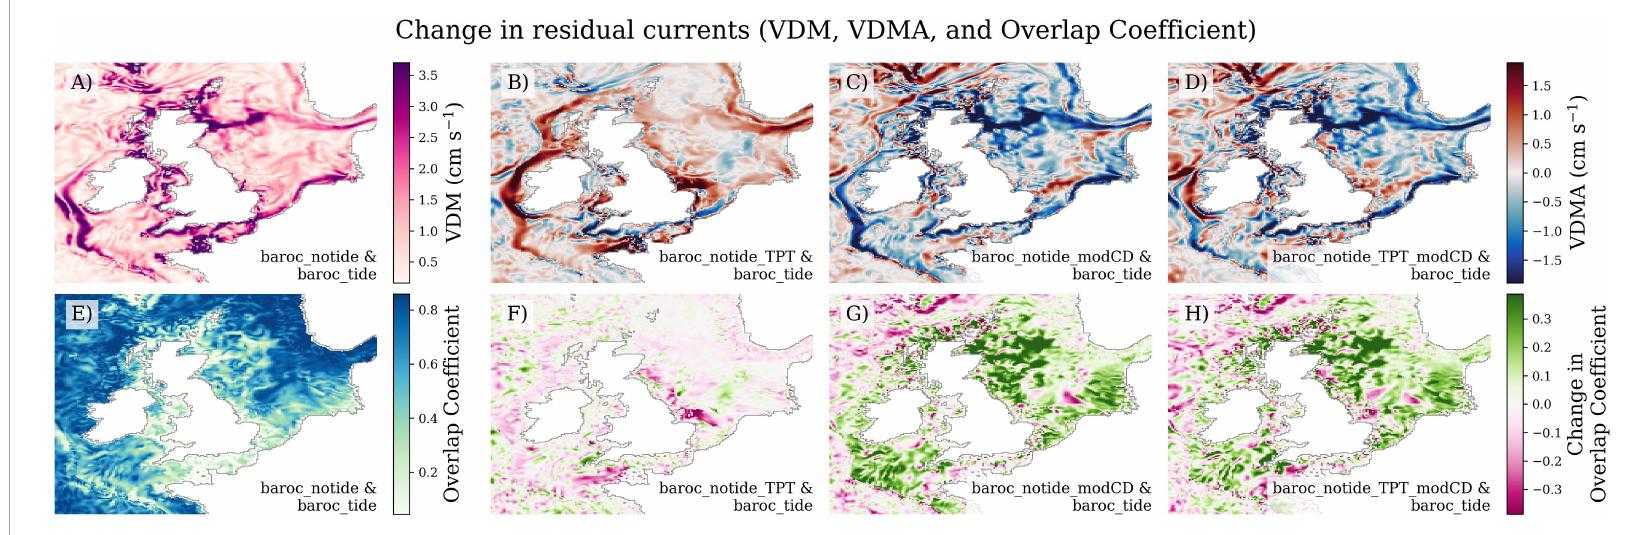
FIGURE 8 Impact of the tides and tidal parameterisations on the depth-mean residual fl ow, in terms of the mean (A – D) and the inter-annual variability (E – H) . (A) VDM baroc_notide , the Vector Difference Magnitude between baroc_tide and baroc_notide (lower numbers show greater agreement between the simulations), and (B – D) the Vector Difference Magnitude Anomaly, showing how (A) changes when adding a tidal parameterisation to baroc_notide (baroc_notide_TPT, baroc_notide_modCD and baroc_notide_TPT_modCD respectively) – negative numbers show where the parameterisation improves the simulation (making it more similar to baroc_tide). (E) The impact of tides on the residual fl ow variability in terms of the Overlap Coef fi cient (OVL) of the residual current bivariate normal distributions between baroc_tide and baroc_notide (higher numbers show greater agreement between the simulations), and (F – H) showing how (E) changes when adding a tidal parameterisation to baroc_notide. For example, (F) is the difference between the OVL of baroc_tide and baroc_notide_TPT, and the OVL of baroc_tide and baroc_notide. Positive numbers show where the parameterisation improves the